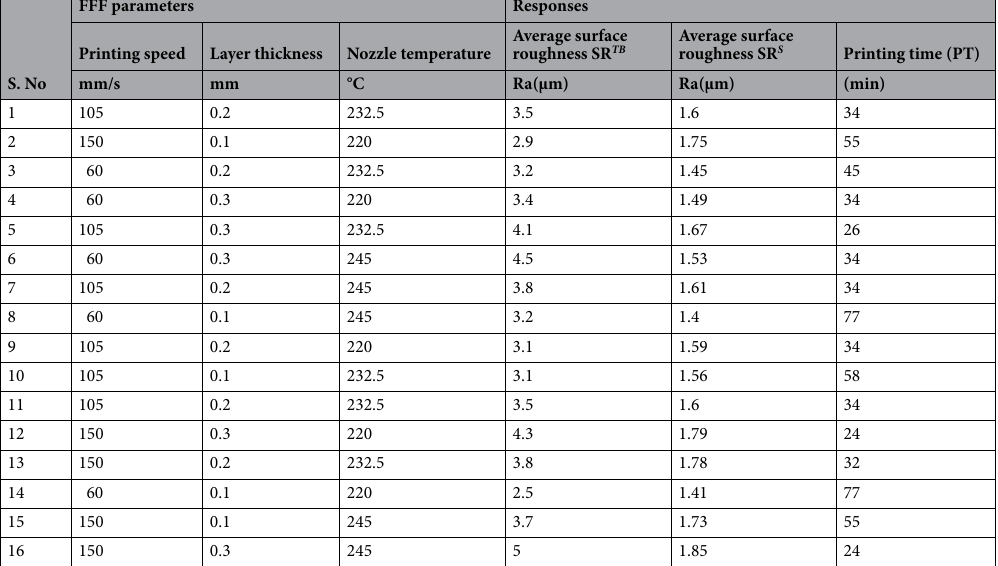
Table 3. Measured surface roughness SR TB , SR S and printing